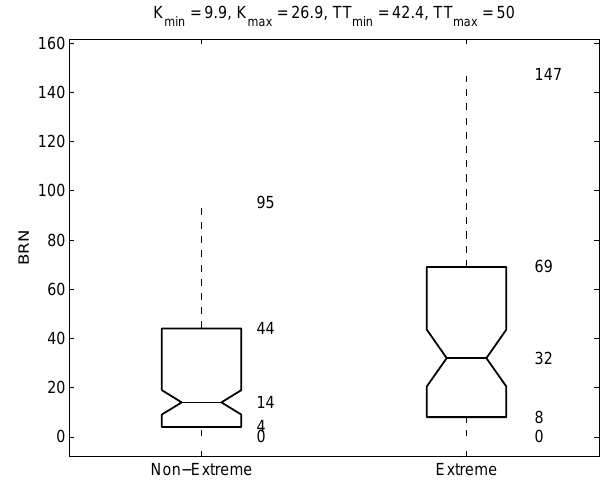
Fig. 4. The distribution of the values of the DCAPE index for the days where extreme (right) and non-extreme (left) events occurred.